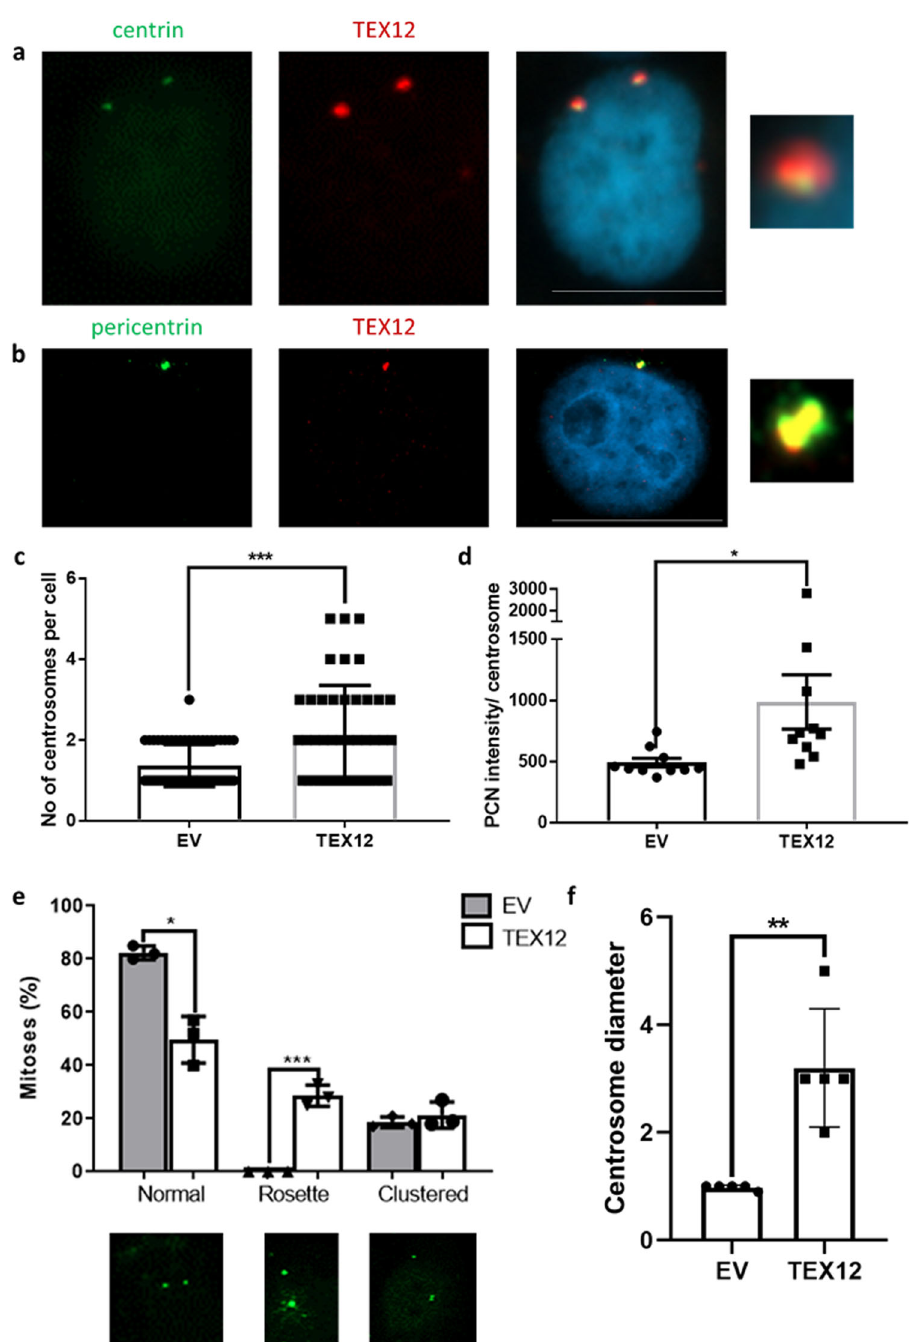
Fig. 3 TEX12 regulates centrosome division. a , b COS-7 cells were transfected with pCMV-HA-TEX12-FLAG for 48 h following by staining for TEX12 (Abcam ab122455) (red) and centrin or pericentrin (green). Bar = 20 µ m. c Centrosome numbers in COS-7 cells 96 h after transfection with TEX12 ( n = 45) or empty vector ( n = 62) were counted in three independent experiments. *** p < 0.005. d COS-7 cells were transfected with empty vector control (EV) or TEX12 for 96 h followed by TEX12 and pericentrin imaging. Average pericentrin intensity per centrosome was quanti fi ed for 10 cells in each group. * p < 0.05. e COS-7 cells were transfected with either empty vector or TEX12 for 96 h followed by centrin staining in green. Mitosis types were quanti fi ed in 100 cells from three independent experiments. * p < 0.05; *** p < 0.005. f Centrosome size ( µ m) in COS-7 cells 96 h after transfection with TEX12 or empty vector was quanti fi ed in 10 cells in four independent experiments. ** p < 0.01. c – f error bars represent standard